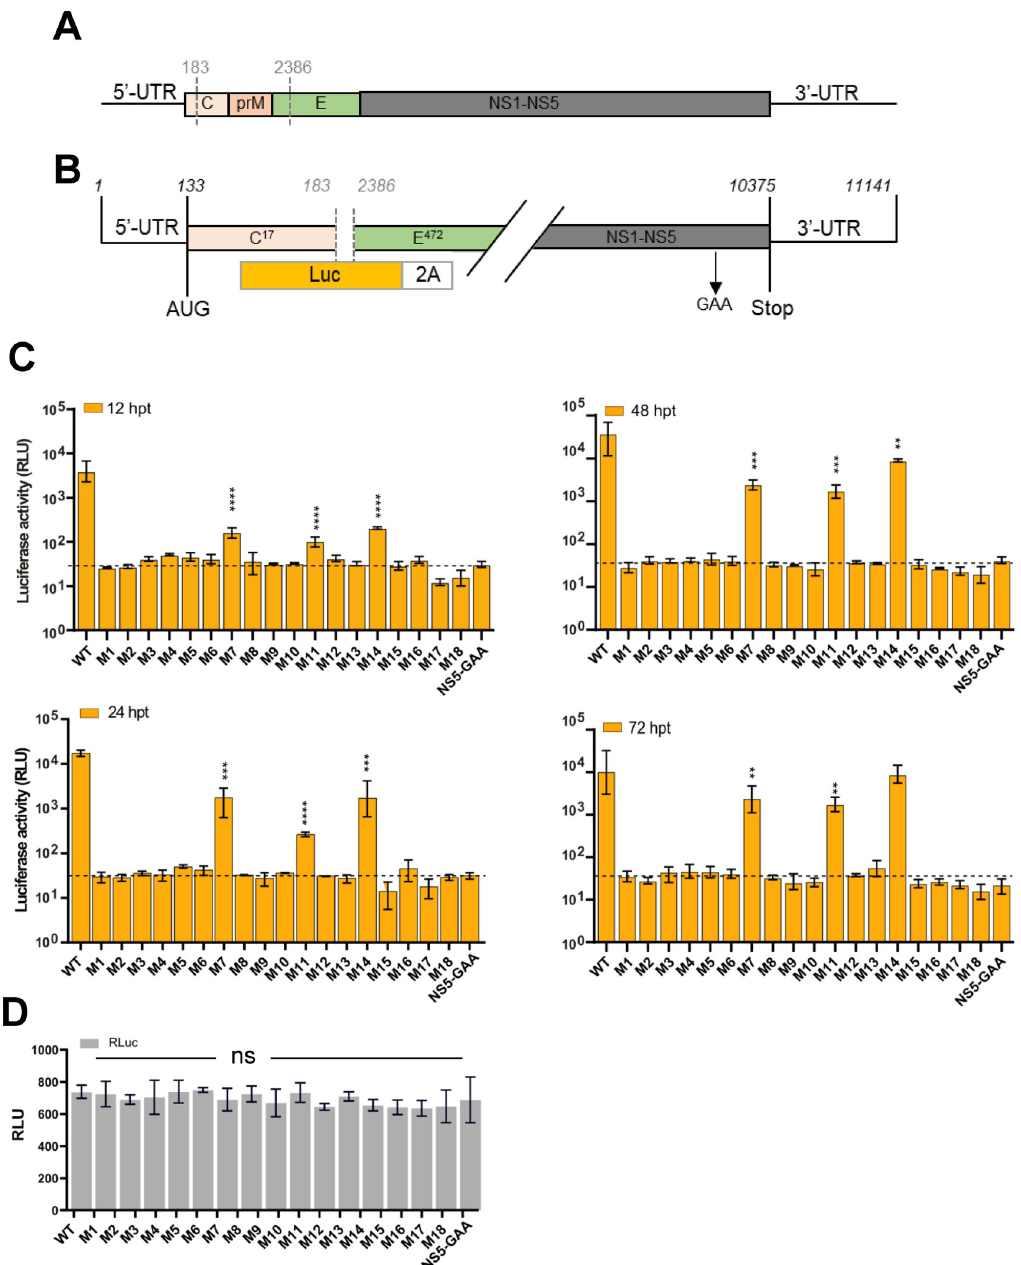
Fig 3. Replication kinetics of the 5 0 UTR mutants. ( A ) Schematic representation of the TBEV genome ( B ) and TBEV replicon in which the structural genes were replaced with firefly (cu) luciferase, and Foot-and-mouth disease virus 2A site (FMDV-2A). The NS5 polymerase inactive site GAA is indicated. ( C ) Luciferase assays in PS cells co-transfected with WT or 5 0 UTR mutants over the indicated time course (12–72 h post-transfection [hpt]). ( D ) Representative quantification of pTK-Ren (Renilla) performed 24 h post-transfection (hpt), showing nonsignificant (ns) differences between mutants. Bar heights are the mean ± SEM of three biological replicates. Assays were performed in triplicate. � P = < 0.01, �� P = < 0.001, ���� P = < 0.0001 versus WT determined using a one-way Anova with Bonferroni’s